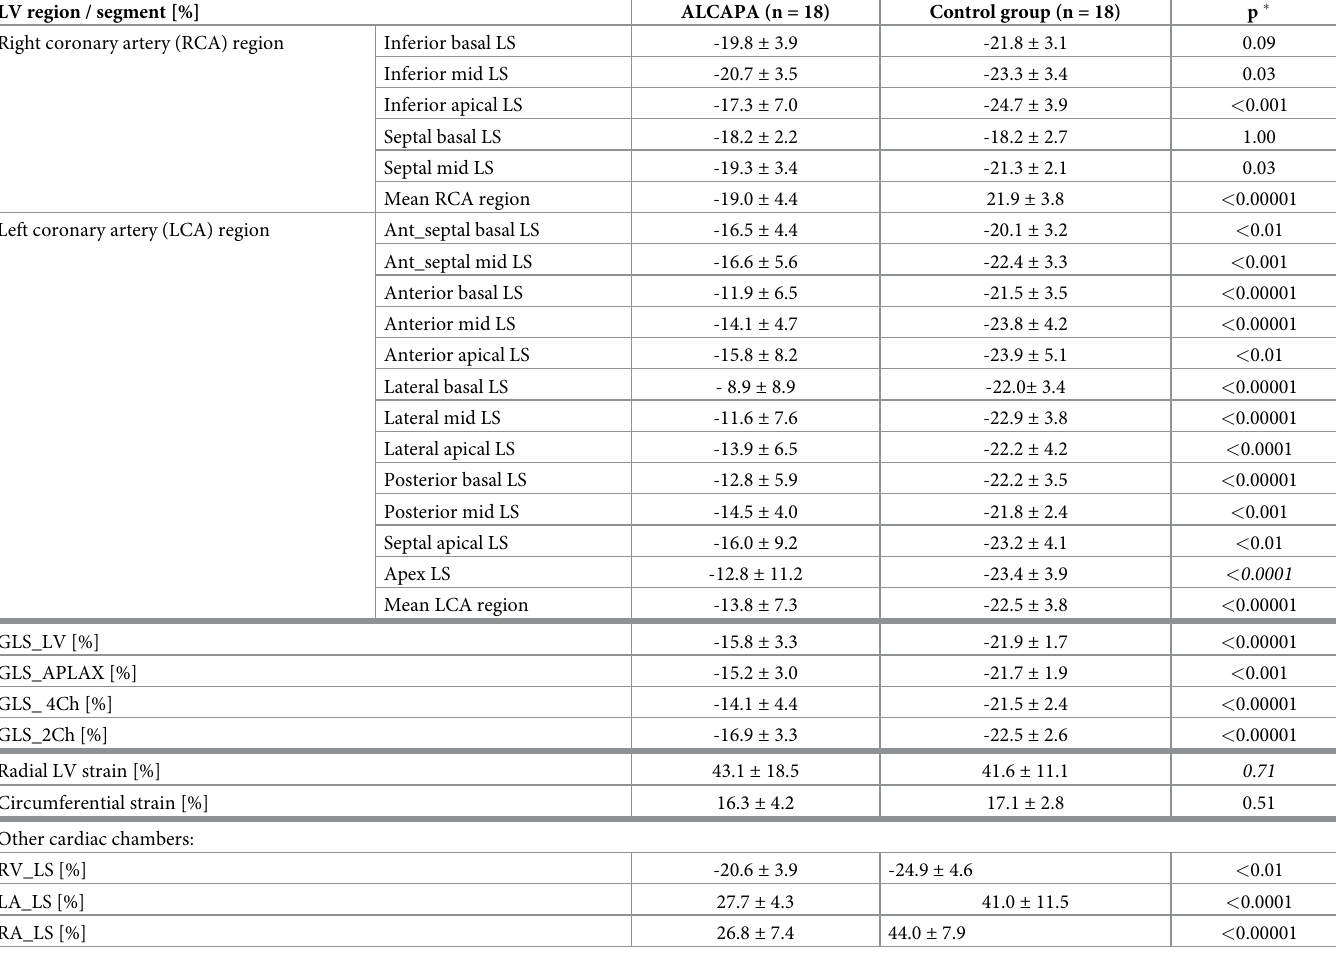
Table 4. Comparison of the 2-dimensional echocardiographic longitudinal speckle tracking strain parameters in the study population at last follow-up and the con- trol group. LV region / segment [%] Right coronary artery (RCA) region